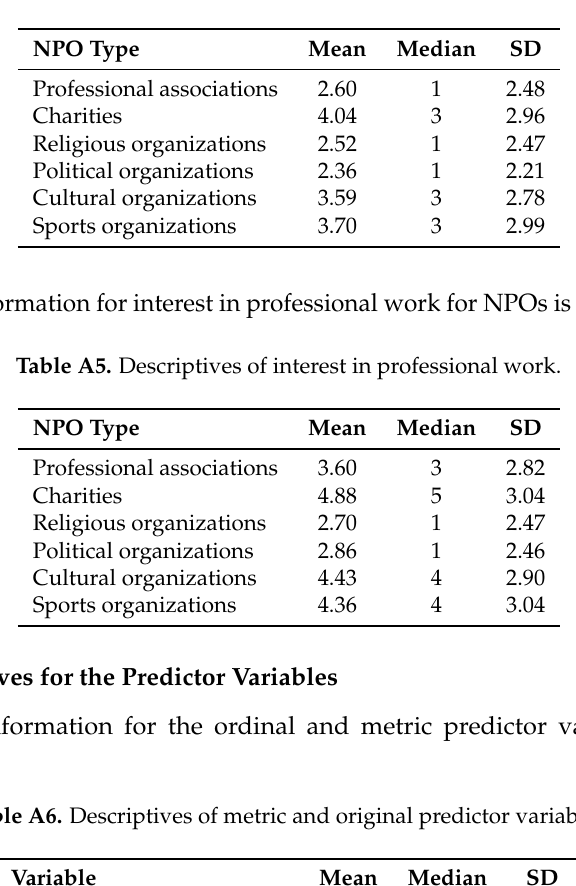
Table A4. Descriptives of volunteering willingness.